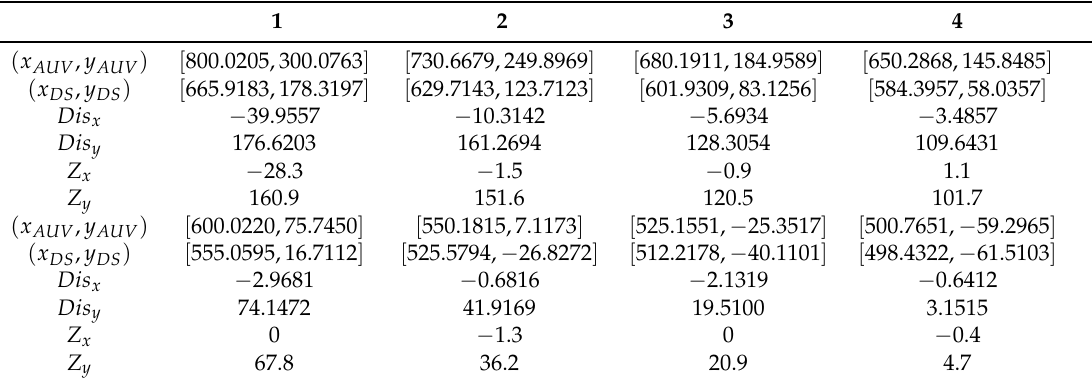
Table 1. Navigation data of our recovery system.